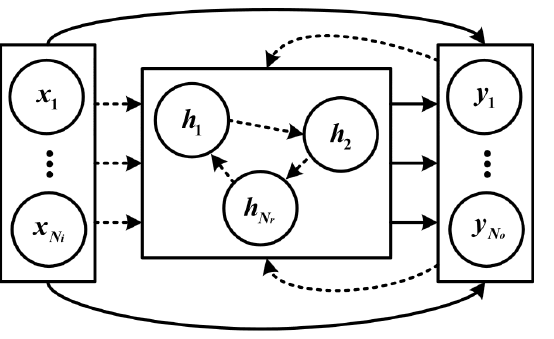
Figure 27. Scheme of an ESN with dashed (random) and solid (trainable) connections. Adapted with permission from [41], © 2018